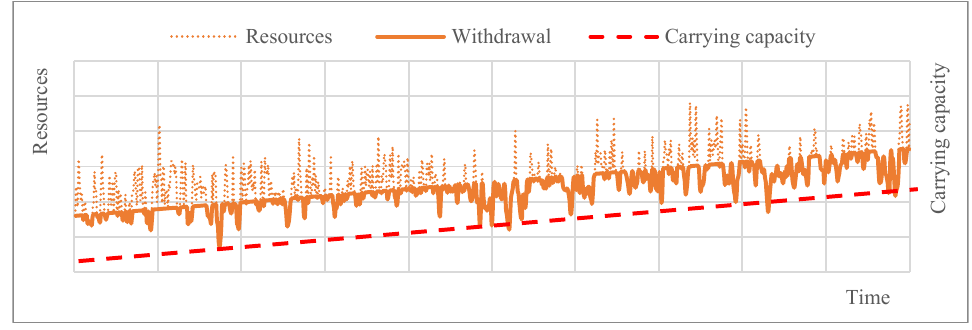
Figure 6. Toy model: The concept of carrying capacity with HK dynamics where storage and technology are increasing.